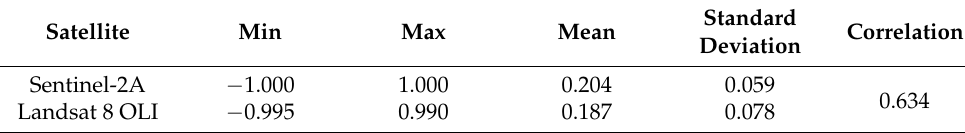
Figure 4. NDVI distribution map calculated by different data sources. ( a ) NDVI form Landsat 8 ( b ) NDVI form Sentinel-2. Table 3. Statistical comparison of NDVI data calculated by different data